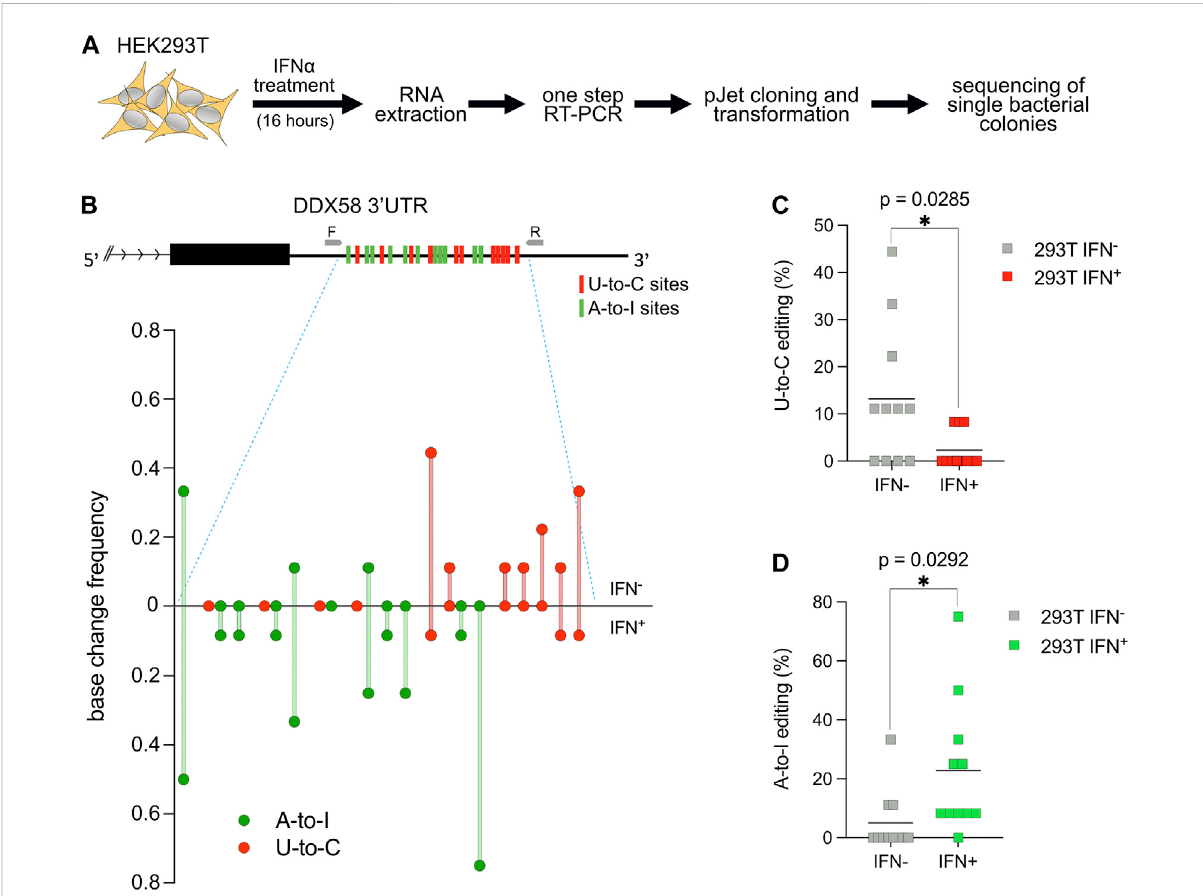
FIGURE 2 U-to-C base changes within DDX58 are dynamic. (A) Flowchart of the experiment. (B) Upper: schematic representing the 11 U-to-C (red bars) and 11 A-to-I (green bars) base changes within the 3 ′ UTR of DDX58 . Primers used for cDNA synthesis and PCR ampli fi cation are indicated as small grey arrows. Lower: Quanti fi cation of base changes within DDX58 3 ′ UTR with and without interferon (IFN) treatment based on sequences from bacterial colonies (Supplementary Figure S2). U-to-Cs and A-to-Is are shown in red and green, respectively. (C,D) Dot plots showing the decrease in U-to-Cs and the increase A-to-Is upon IFN treatment. Each dot = one single site; line = mean. A two-tailed unpaired t -test was used to compare the differences (* p <